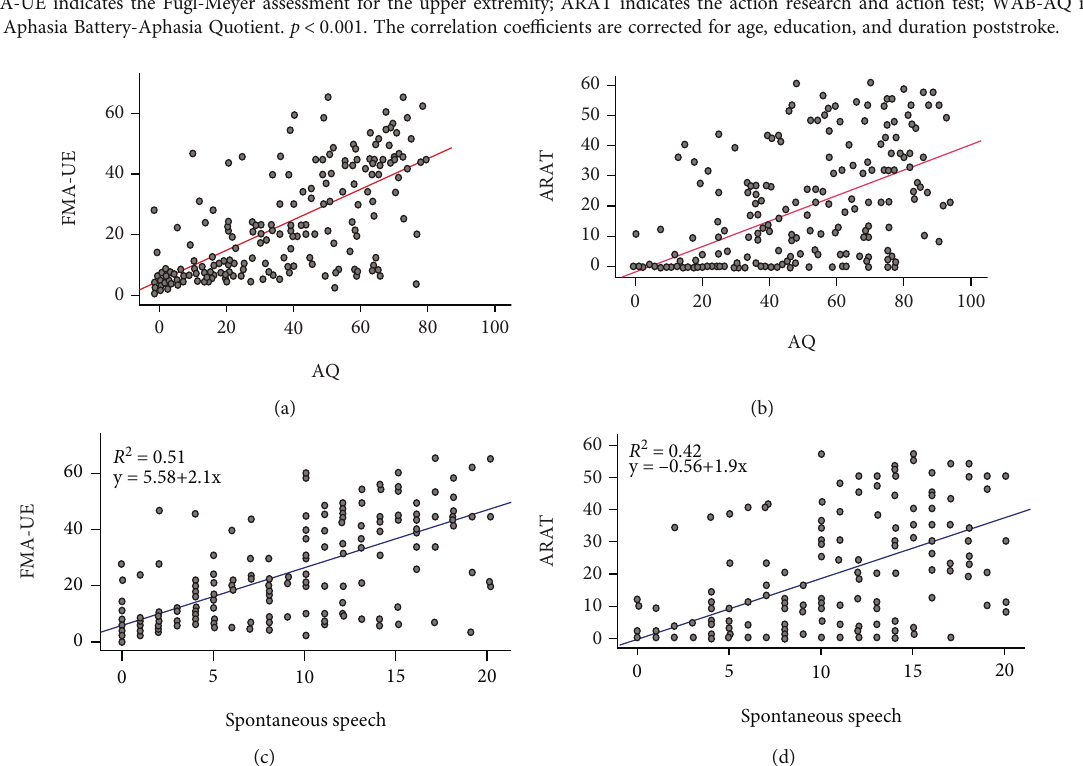
† Correlation analyses of the overall time period. ∗ Correlation analyses of 1-3 months. ∗∗ Correlation analyses of 4-6 months. ∗∗∗ Correlation analyses of > 6 months. FMA-UE indicates the Fugl-Meyer assessment for the upper extremity; ARAT indicates the action research and action test; WAB-AQ indicates the Western Aphasia Battery-Aphasia Quotient. p < 0 : 001 . The correlation coe ffi cients are corrected for age, education, and duration poststroke.